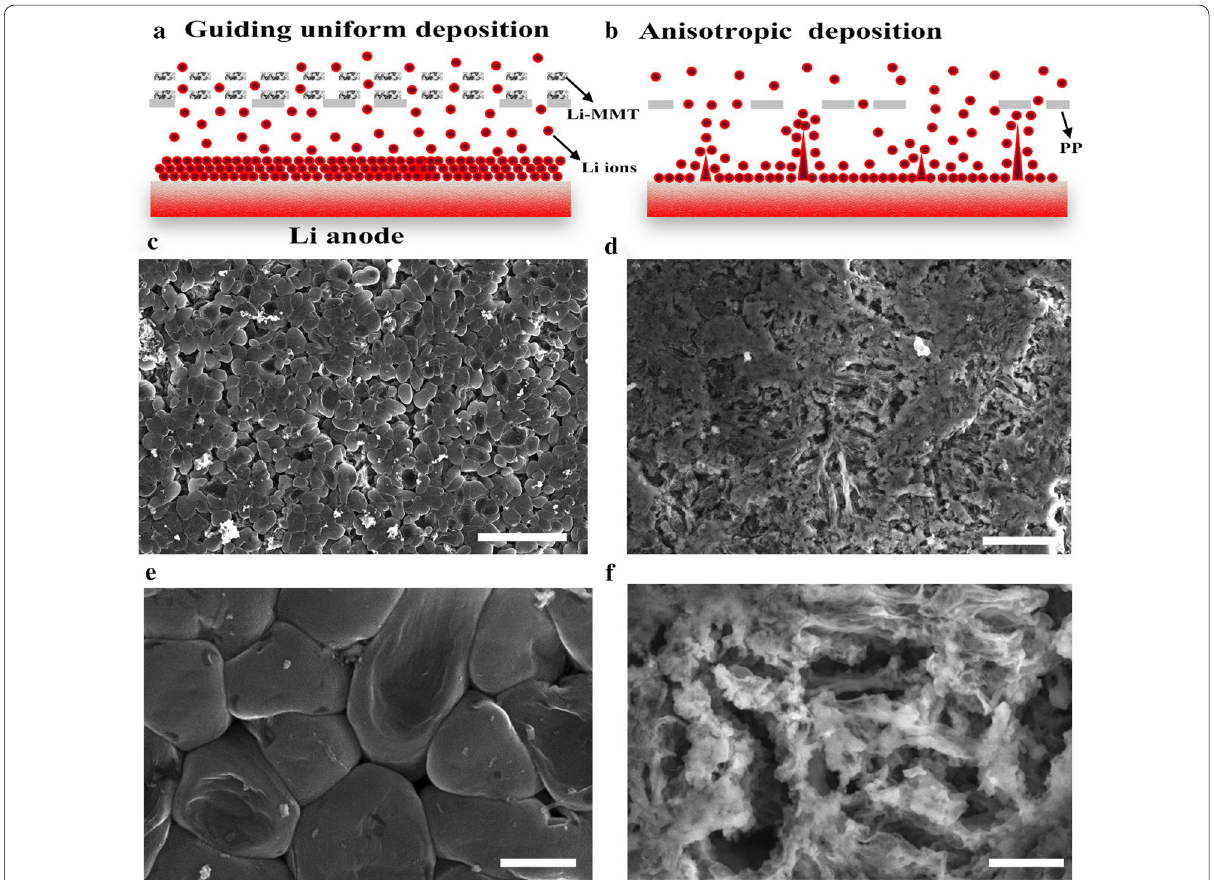
Fig. 3 SEM images of Li anode coupled with Li-MMT@PP or PP separator after 20 cycles at 1 mA cm − 2 with a capacity of 1 mAh cm − 2 . a , b Mechanism illustration of Li-MMT@PP or PP separators. c , e Li-MMT@PP separator. d , f PP separator. Scale bars: c 25 µm, d 10 µm, e , f 2.5